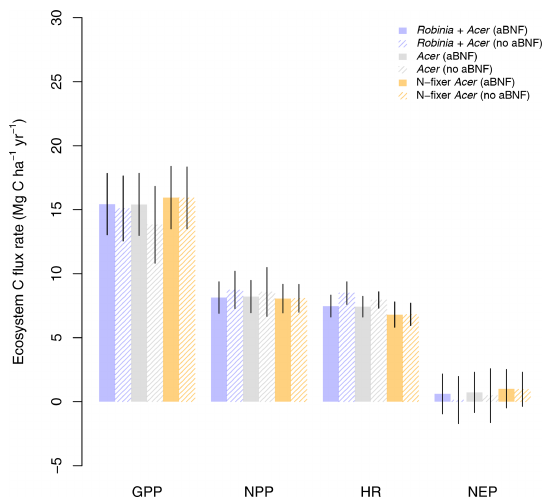
Figure D8. Simulated gross primary production (GPP), net primary production (NPP), heterotrophic respiration (HR), and net ecosystem production (NEP) from LM4.1-BNF initialized with both Robinia and Acer , only Acer , and only N-fixer Acer , with and without asymbiotic BNF. Simulated data are averaged over the last 100 of the 300 years of simulation to reflect the data which are from mature forests. Error bars indicate 2 standard